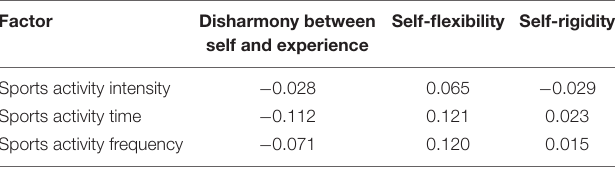
TABLE 5 | Correlation matrix between college students’ sports activity participation and self-harmony.